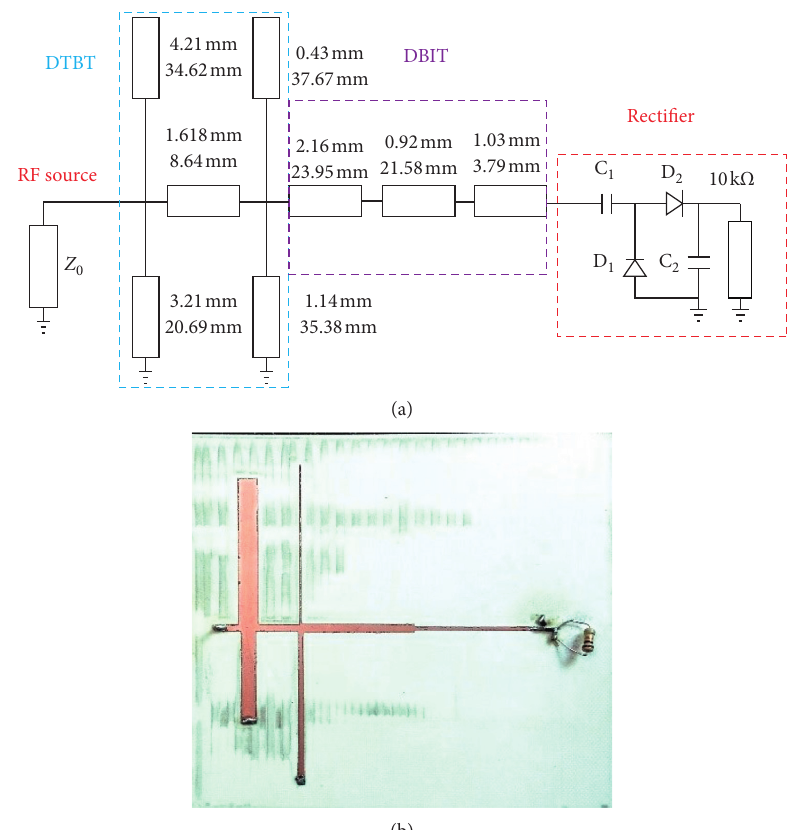
Figure 22: Schematic and prototype of the proposed Triband rectifier (PCB size: 7 × 7.5cm 2